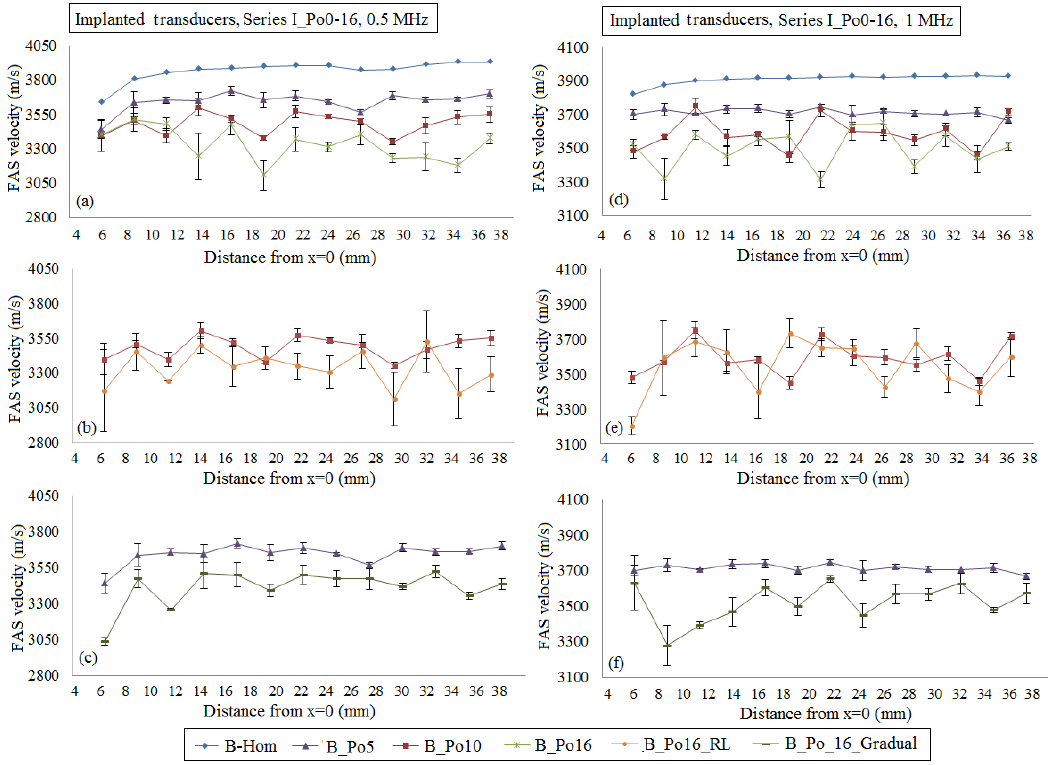
Figure 4. The potential of the mean local FAS velocity to detect changes in cortical porosity from 0%–16%. The diagrams correspond to the first set of simulations under the assumption of implanted transducers and the excitation frequencies: ( a )–( c ) 0.5 MHz; and ( d )–( f ) 1 MHz. The standard error bars demonstrate the FAS velocity variation for the three numerical models established for each porosity scenario.